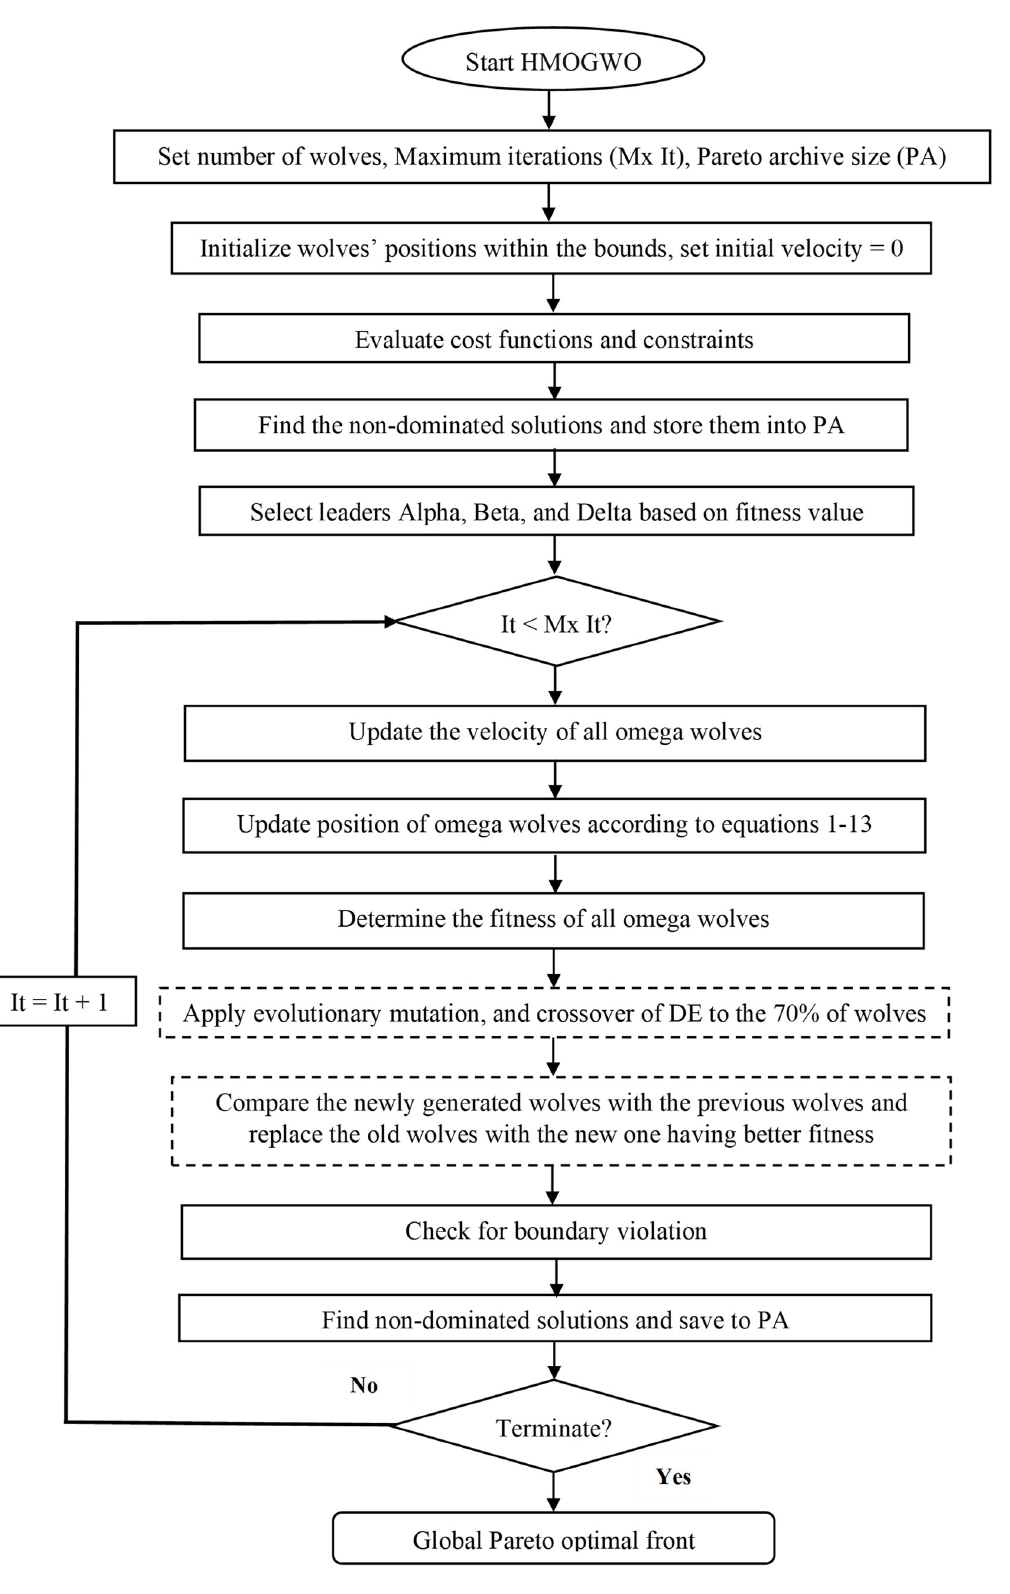
Fig 3. Working principle of HMOGWO.